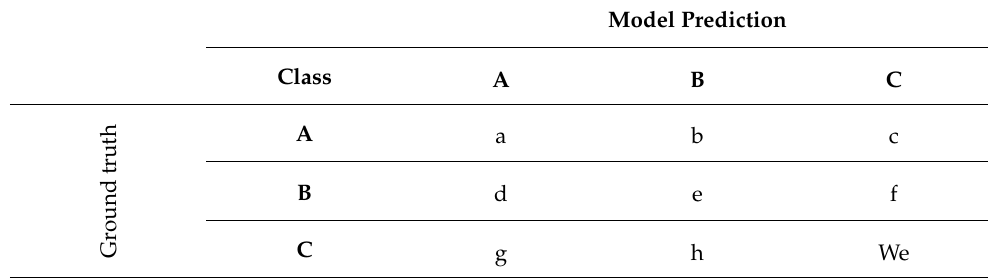
Table 3. Sample matrix of classification